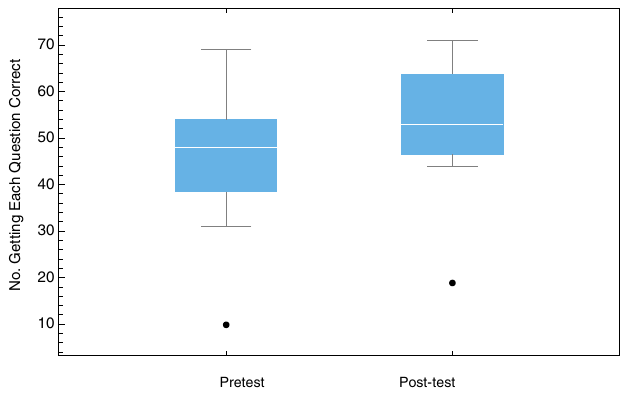
FIG. 2. Box plots for the 11 questions and the number of students getting them correct, for the pretest on the left and the post-test on the right. The bottom and top of the blue boxes represent the 25th and 75th percentiles, respectively, the white line in the center represents the median value (50th percentile), and the whiskers represent the highest and lowest values, excluding any outliers. The outlier (black dot) in both represents question